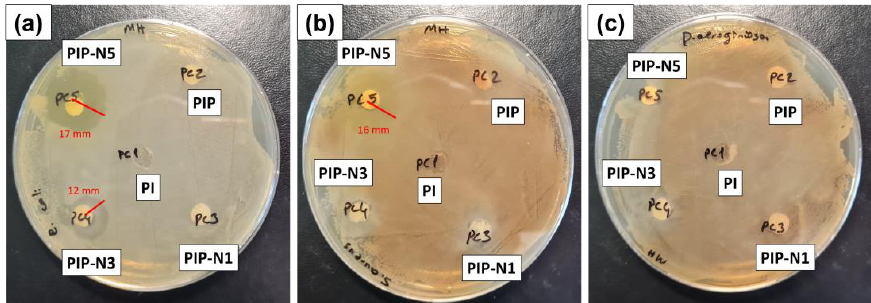
aureus , and ( c ) P. aeruginosa. ( b ) S.